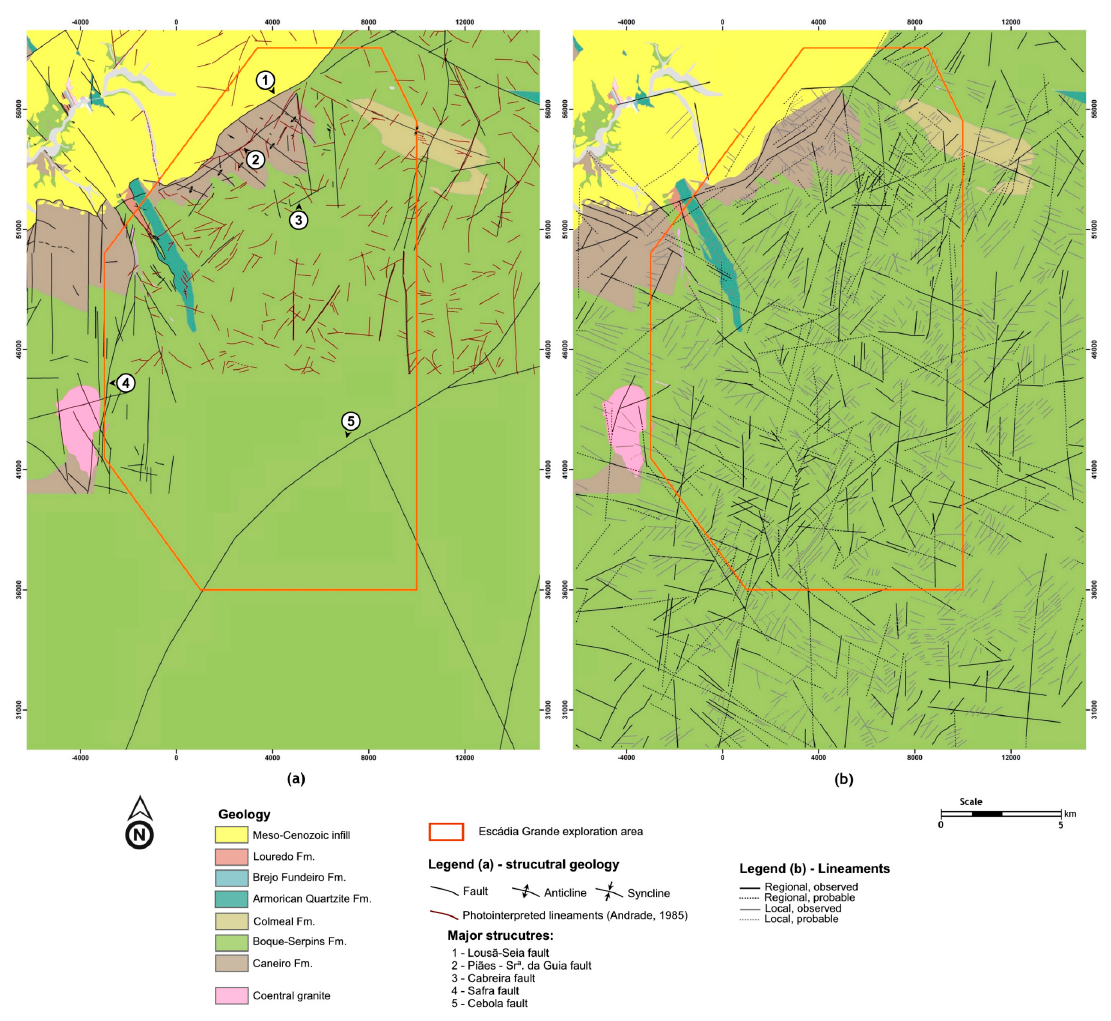
Figure 17. ( a ) Available geological base-information (Sheet19-D (Coimbra-Lousã), Geological map of Portugal 1:50,000; Geological map of Portugal 1:500,000; [18–20]); ( b ) mapped lineaments, as shown in Figure 13.